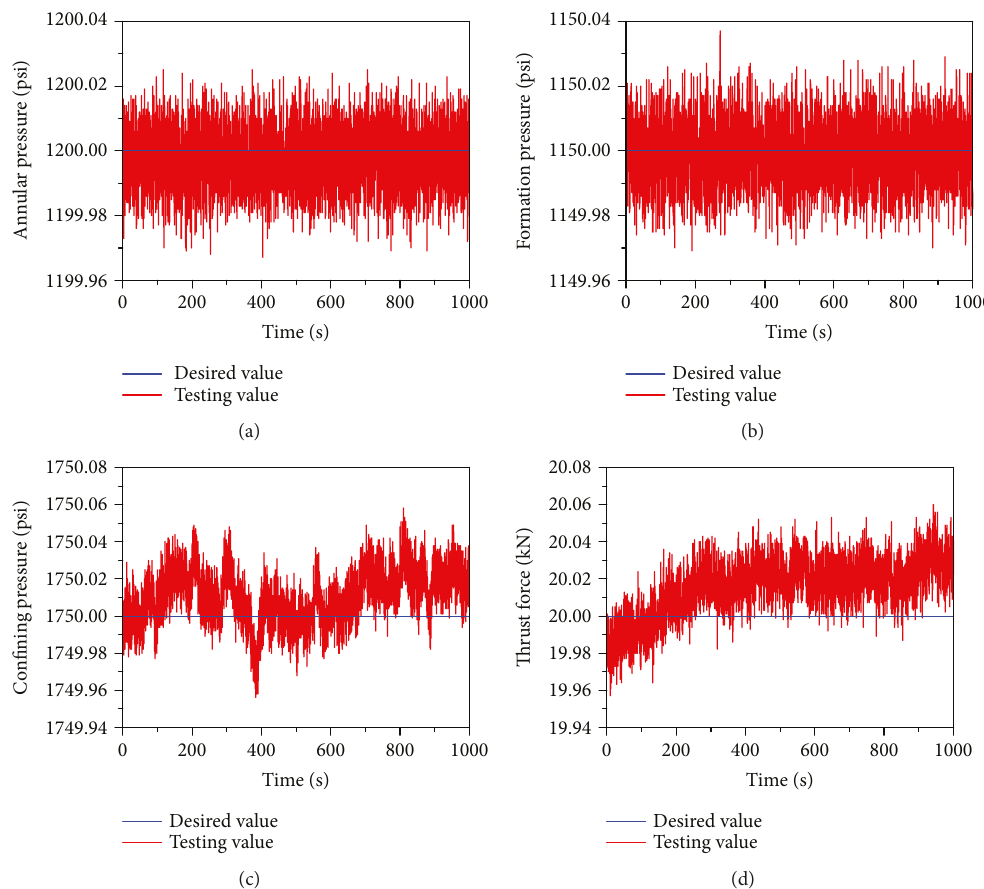
Figure 12: Debugging data of annular pressure, pore pressure, con fi ning pressure, and thrust force under a given value in 1000 seconds. (a) Annular pressure versus time. (b) Formation pressure versus time. (c) Con fi ning pressure versus time. (d) Thrust pressure versus time.